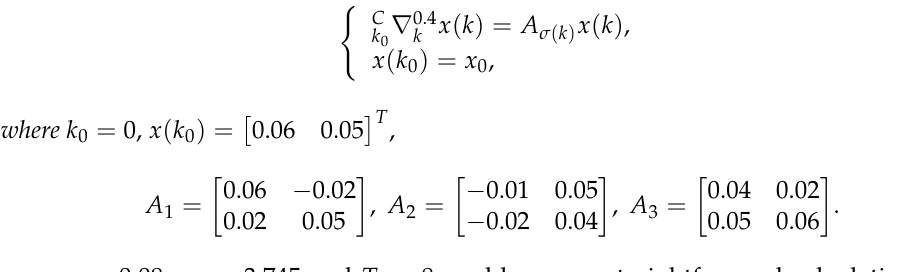
Figure 3. The switching signals  ( ) k .